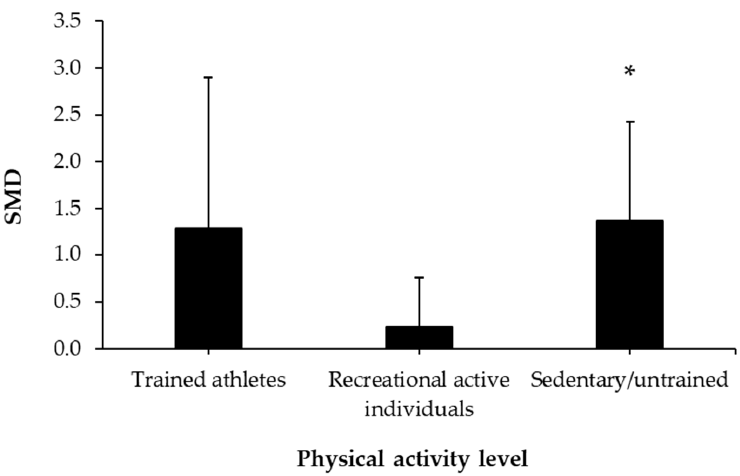
Figure 4. E ff ect of ca ff eine ingestion as compared to a placebo on the fat oxidation rate during exercise, depending on the physical activity level of the individuals. SMD values represent the standardized mean di ff erences obtained with a meta-analysis of 19 studies and the bar represents 95% confidence intervals for the SMD in group of participants. (*) The e ff ect of ca ff eine in this group was statistically significant, with a higher fat oxidation rate observed compared to placebo ingestion ( p < 0.05). The heterogeneity was large for the overall e ff ect of ca ff eine on fat oxidation during exercise (I 2 = 82%), as well as in the subanalyses performed with the dose of > 6.0 mg / kg of ca ff eine (I 2 = 92%) and in the samples of trained athletes (I 2 = 92%) and sedentary or untrained individuals (I 2 = 82%). On the other hand, medium heterogeneity values were observed for the e ff ect of ca ff eine on fat oxidation after taking ≤ 3 mg / kg of ca ff eine (I 2 = 67%) and between 3.1 and 5.9 mg / kg of ca ff